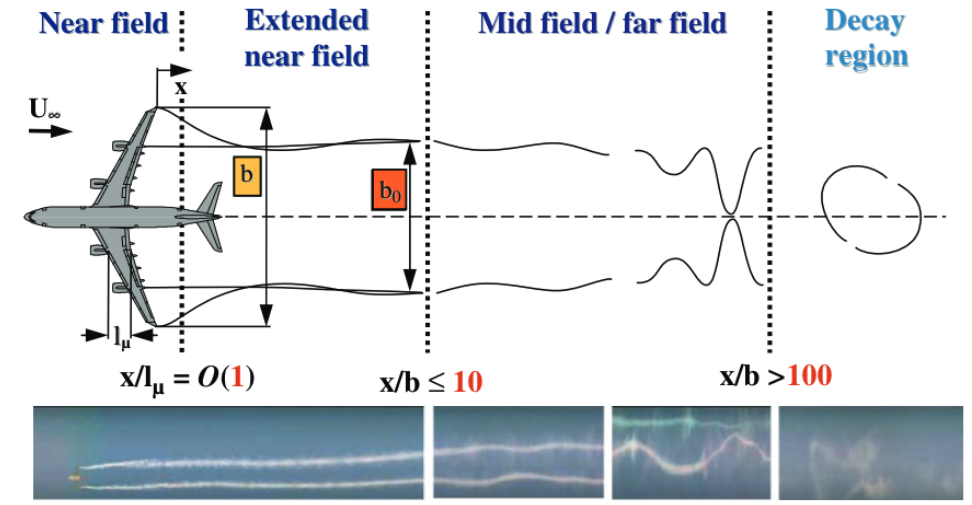
Figure 4. The evolution of the vortex pair [27]. Reprinted with permission from